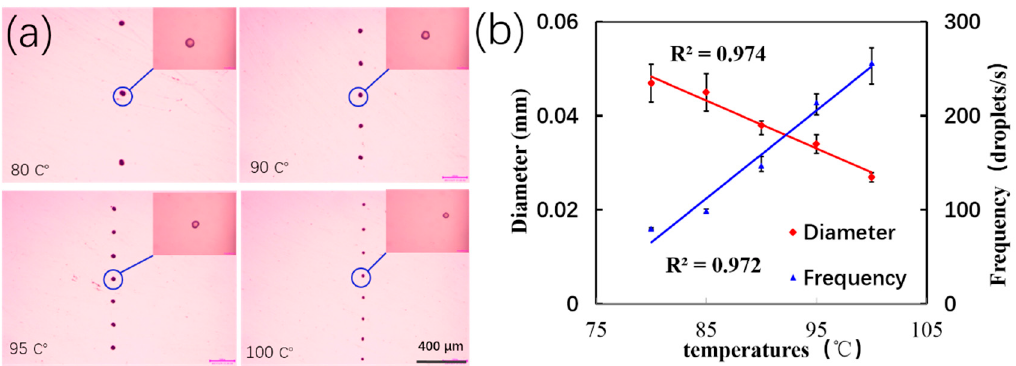
Figure 4. ( a ) Morphology of wax droplets at di ff erent temperatures. The background of the picture has been processed. ( b ) The relationship of diameter and frequency of wax droplets at di ff erent heating temperatures. Collection distance: 3 mm; electric field voltage: 5 kV; collecting plate moving speed: 40 mm / s.